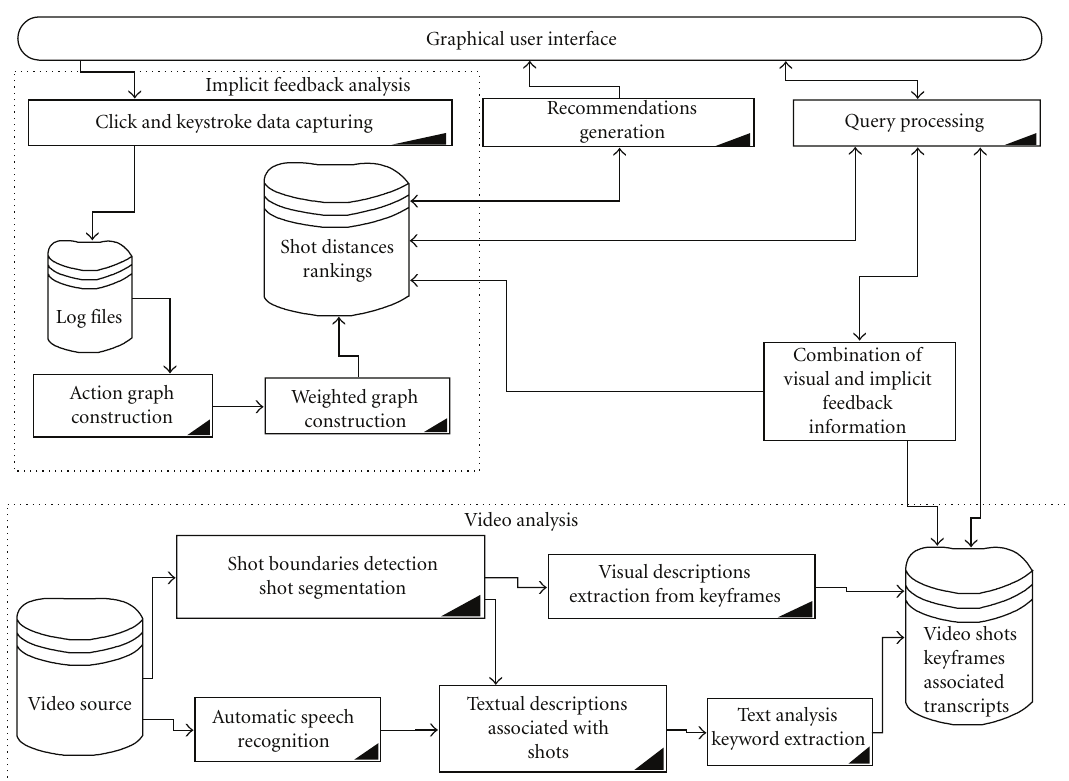
Figure 1: Video indexing and retrieval